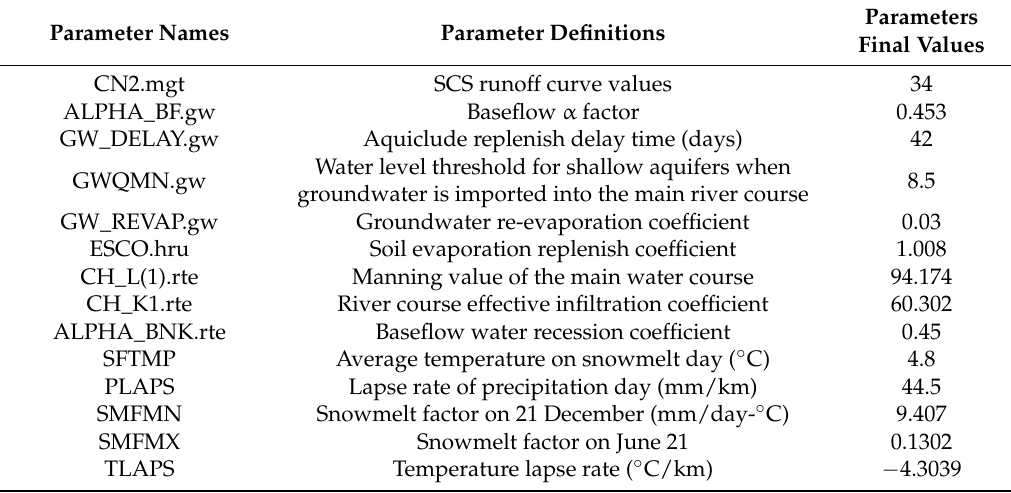
Table 3. The final values of the SWAT model’s